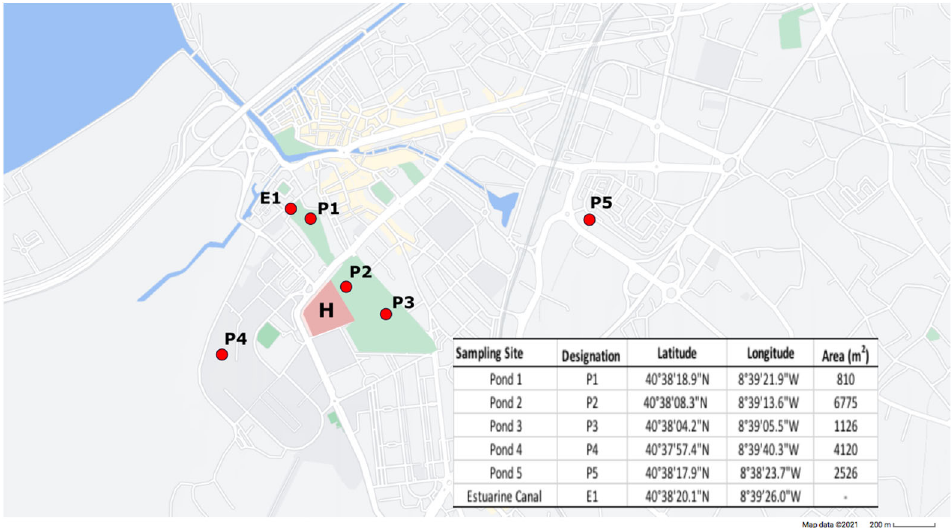
Figure 1. Map depicting the location, designation and coordinates of the sampled ponds (P1–P5) and estuarine canal (E1). Green areas indicate the location of urban parks, while blue areas represent the Ria de Aveiro urban canals. The location of the municipal hospital is also denoted (H).